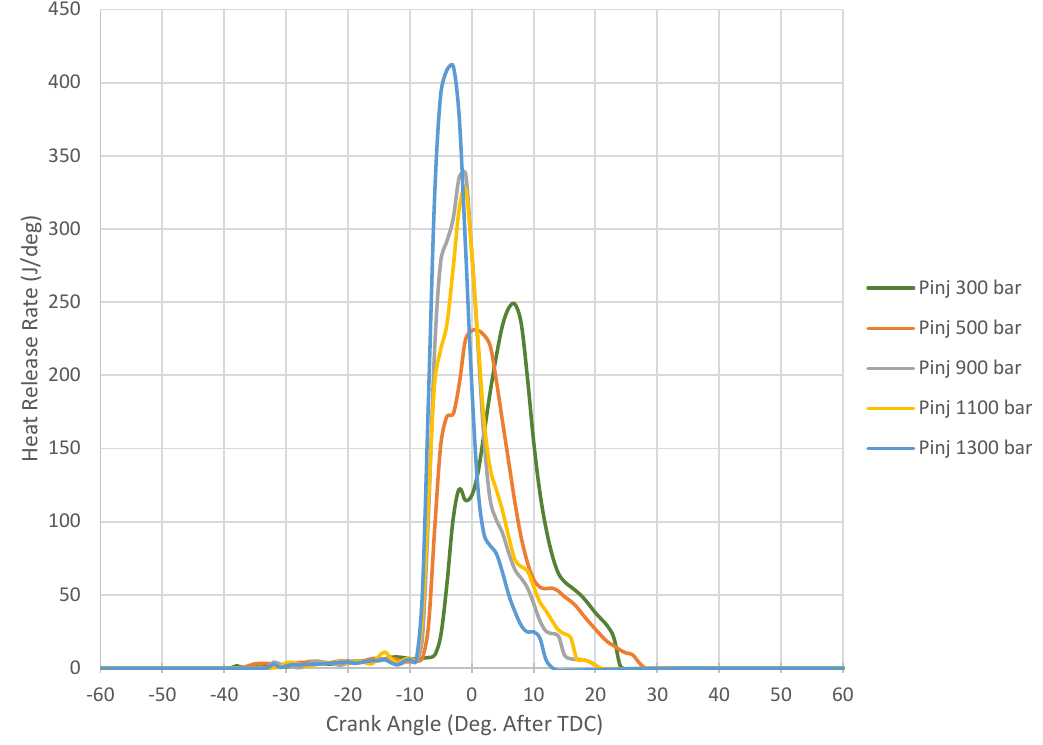
Figure 7. Heat release rate versus crank angle (SOI = 17° BTDC).